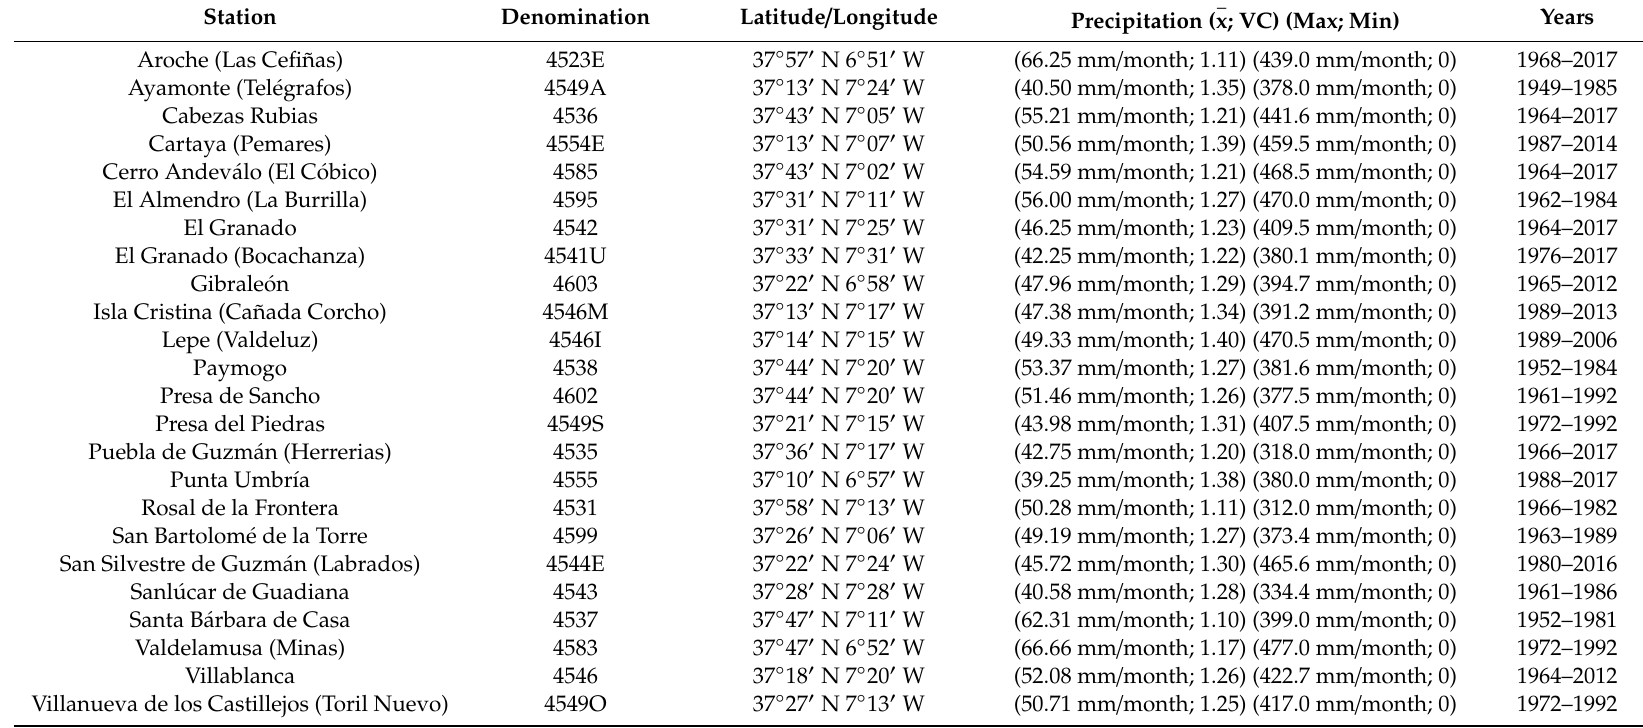
Table 4. Characteristics of Spanish climatic stations distributed over the Lower Guadiana River Basin (control network Agencia Estatal de Meteorolog í a de España − (AEMET), Figure 2) ( x = monthly mean precipitation in mm / month; VC = variation coe ffi cient; max = monthly maximum precipitation in mm / month; min = monthly minimum precipitation in mm / month)